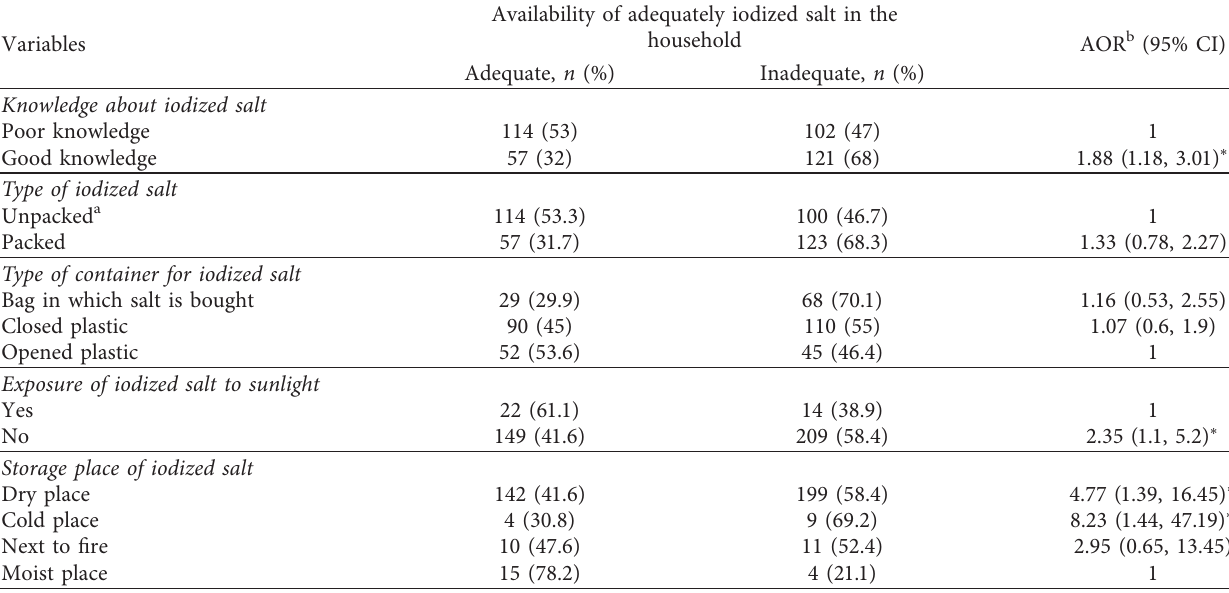
Table 3: Factors associated with the availability of adequately iodized dietary salt at household level in Kore Town, Southeast Ethiopia, 2019.